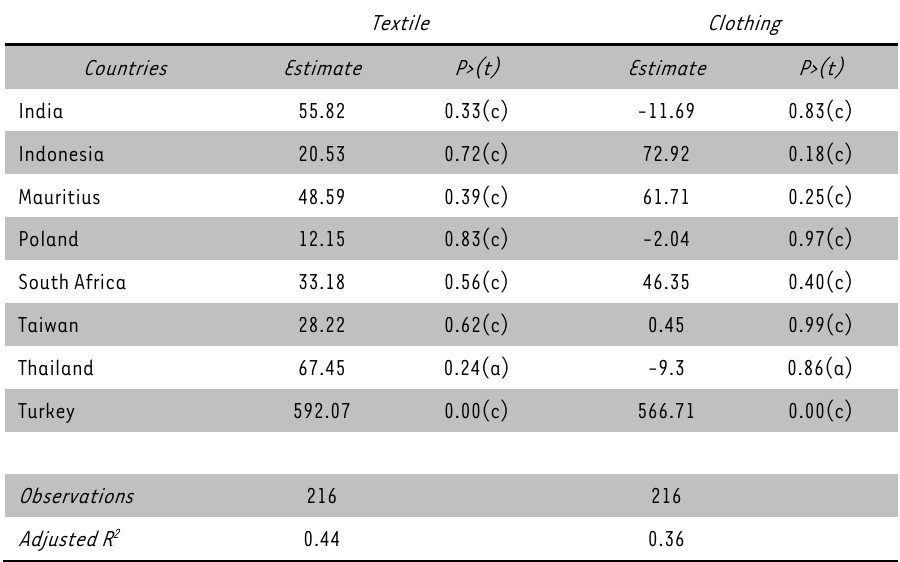
TABLE 3: Fixed-effect panel data ULC estimates (China as the benchmark)